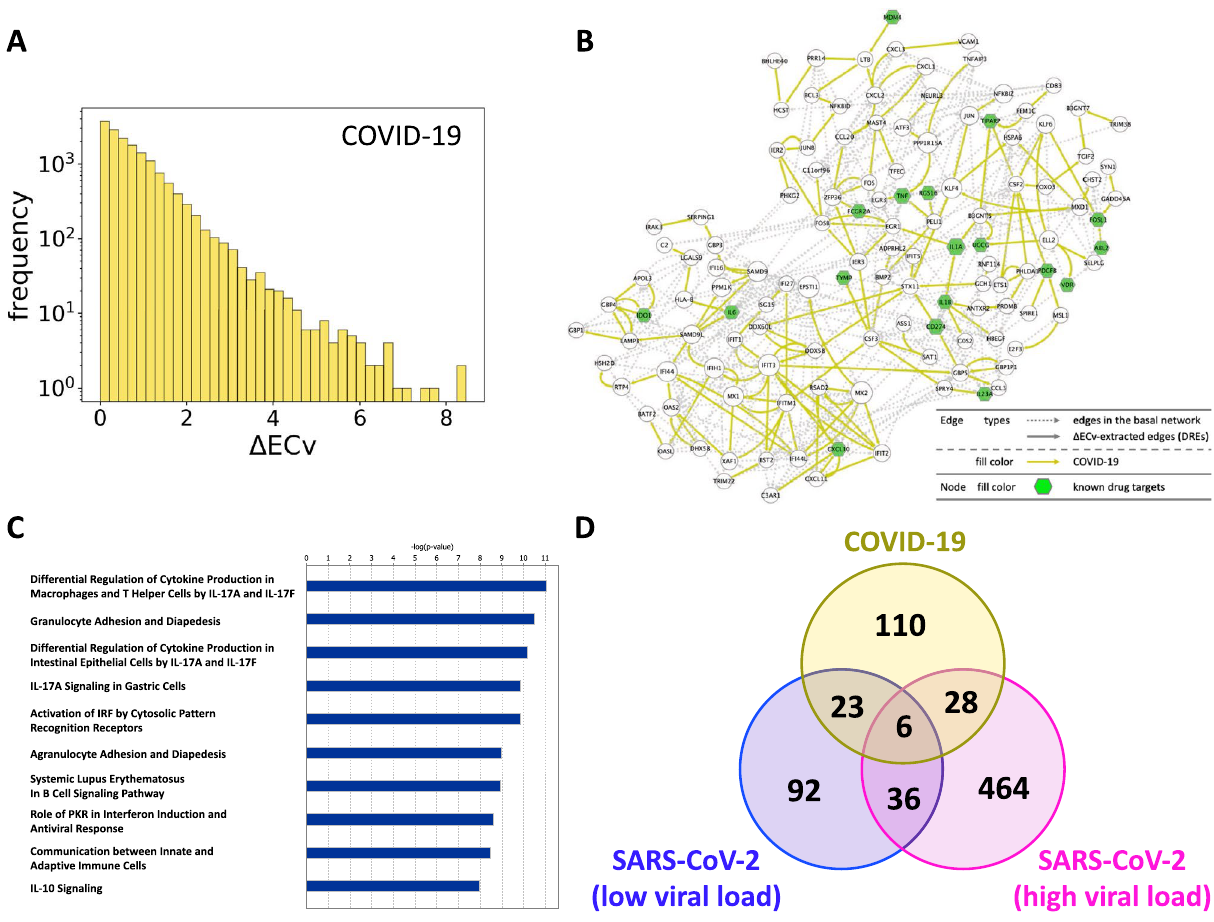
Figure 5. The COVID-19-perturbed network analysis. ( A ) The histograms of (cid:31) ECv for the biopsy dataset. The X-axis corresponds to the threshold for the (cid:31) ECv. The Y-axis stands for the number of edges with log scale. ( B ) The COVID-19-perturbed network is shown. The network is composed of 127 nodes and 412 edges (including 245 basal edges). The colored solid edges represent DREs perturbed by COVID-19 (yellow). The dotted edges represent the basal edges (gray). The nodes (green) represent the known drug target genes (Supplementary Table S2). The node size represents the extent of outdegree. ( C ) The top 10 terms of canonical pathway analysis for the genes in the COVID-19-perturbed network. ( D ) The Venn diagram shows the numbers of the (cid:31) ECv- extracted DREs ( (cid:31) ECv threshold 2.3) induced by COVID-19 perturbation for the biopsy dataset (yellow) overlapped with the two DREs through the Venn diagram analysis in Fig.